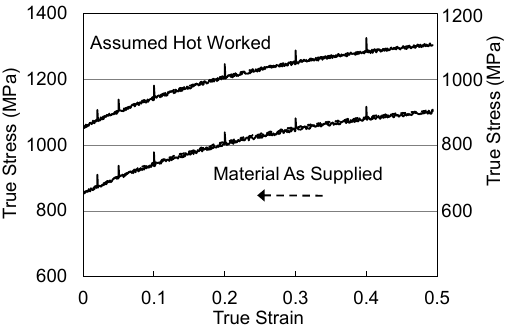
Figure 11. Stress–strain curves and stress response to ×10 strain rate increase.